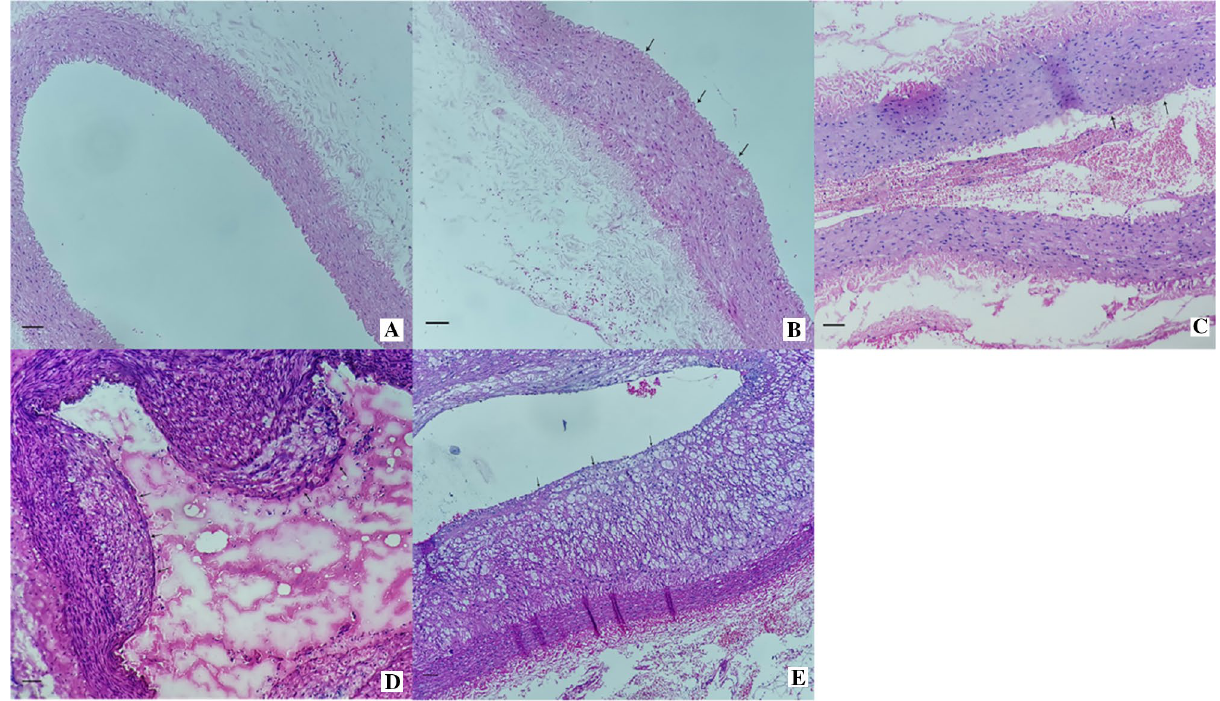
Figure 7. Rabbit abdominal aorta stained by hematoxylin and eosin (× 100). ( A ) Control group; ( B ) Week-4 group; ( C ) Week-8 group; ( D ) Week-12 group; ( E ) Week-16 group. scale bar shows 100 μm.